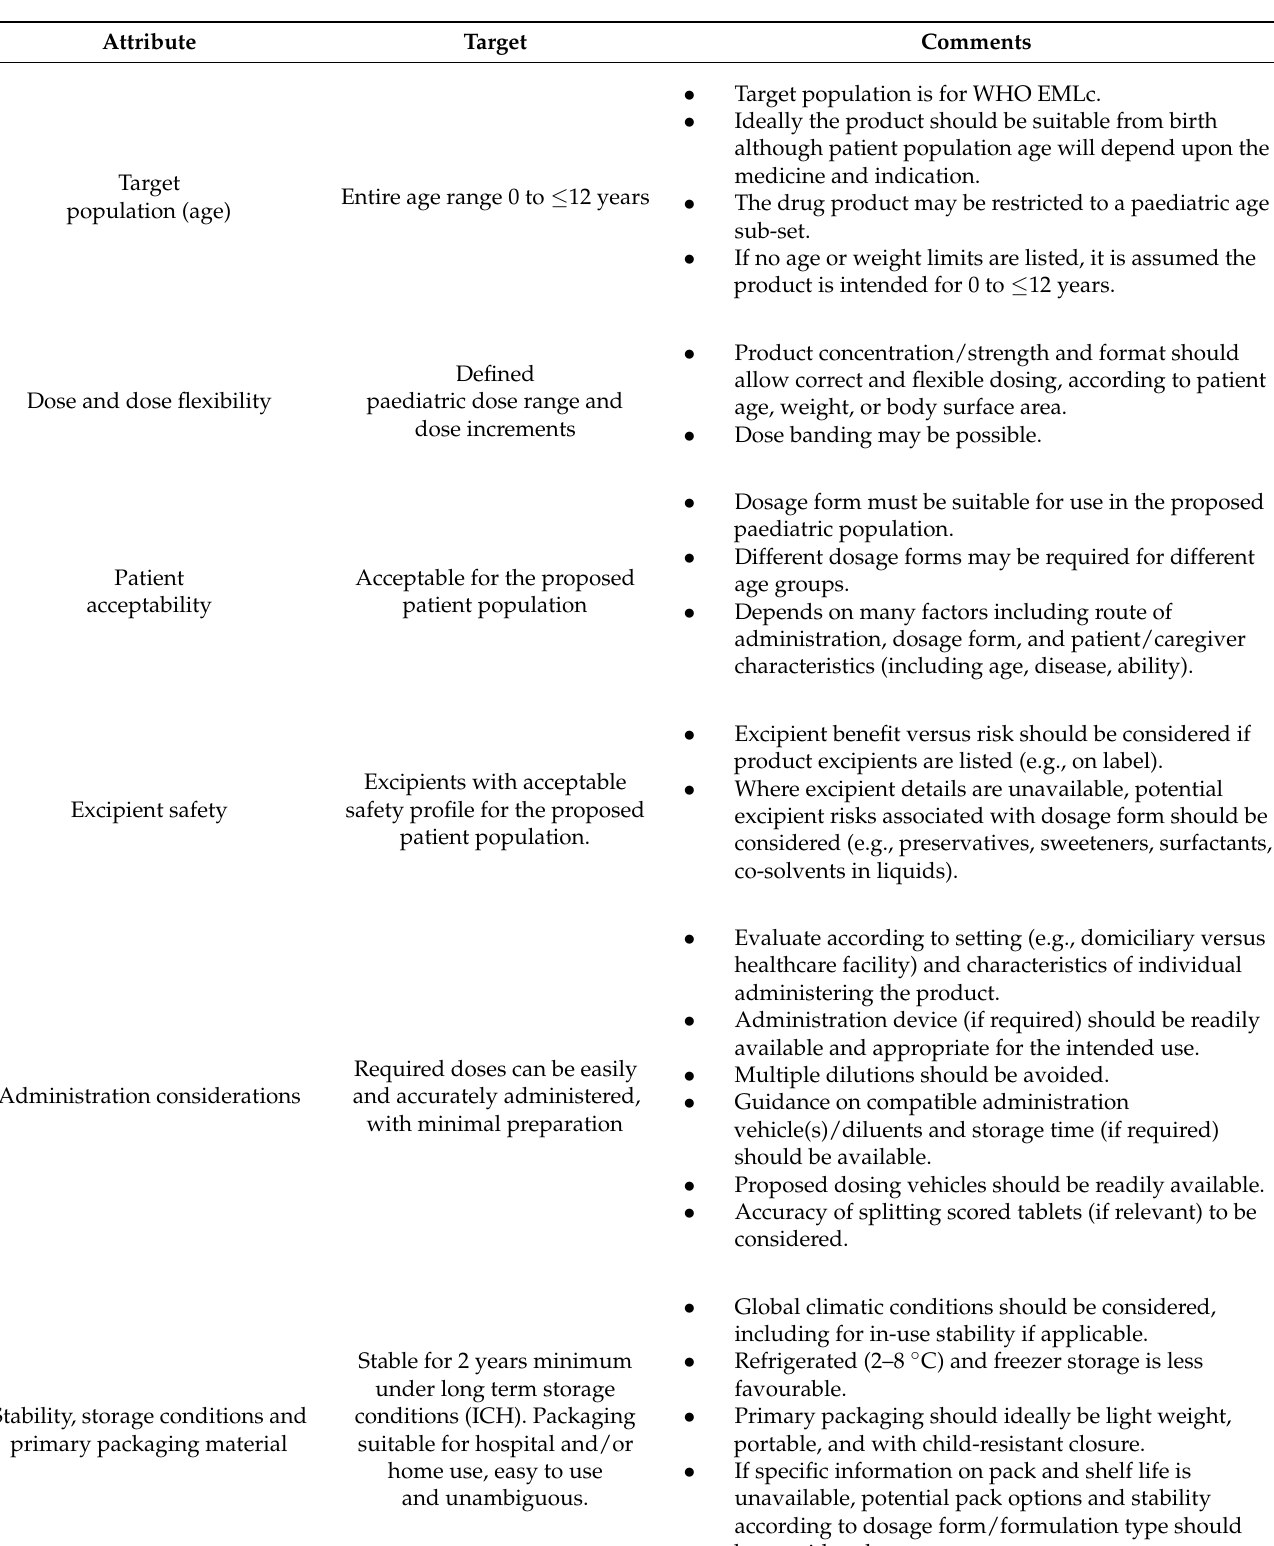
Table 1. Paediatric Quality Target Product Profile attributes and